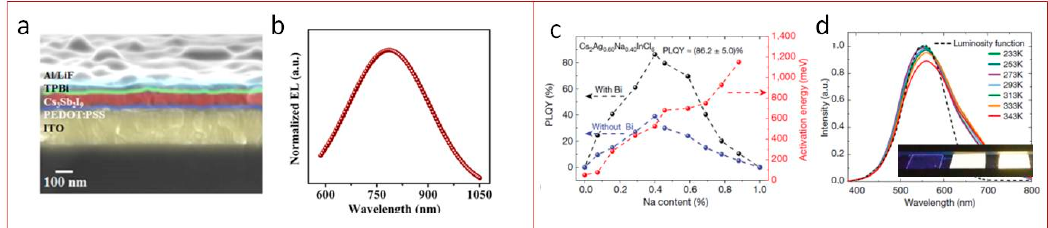
Figure 3. Lead-free film perovskite-based LEDs. ( a ) Cross-sectional SEM image of device; ( b ) normalized electroluminescence (EL) spectrum of the Cs 3 Sb 2 I 9 film. Reproduced with permission [73]. Copyright American Chemical Society, 2019. ( c ) Activation energy and photoluminescence quantum yields (PLQY) of Cs 2 Ag x Na 1 − x InCl 6 powder vs. Na content. The dashed lines are guides for the eye. ( d ) Cs 2 Ag 1 − x Na x InCl 6 Luminosity function (dashed line) and photoluminescence spectra (solid lines) of Cs 2 Ag 0.60 Na 0.40 InCl 6 measured at different temperatures from 233 K to 343 K. Reproduced with permission [74]. Copyright Springer Nature Limited, 2018.